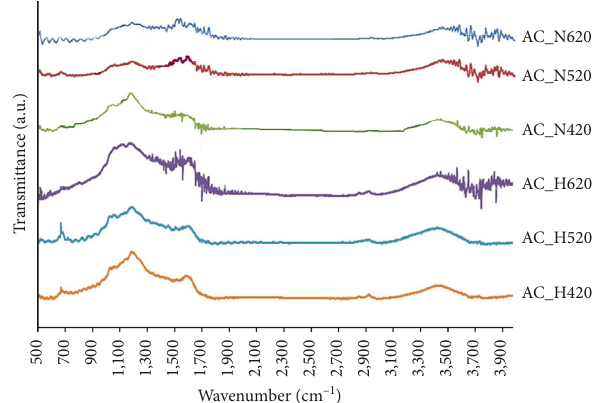
Figure 4: FTIR spectra of the